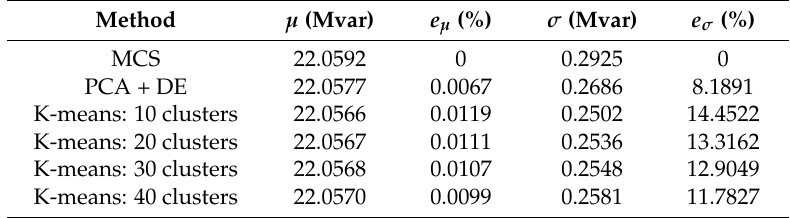
Table 3. Comparison of results from different methods for reactive power flow through line 26–25.